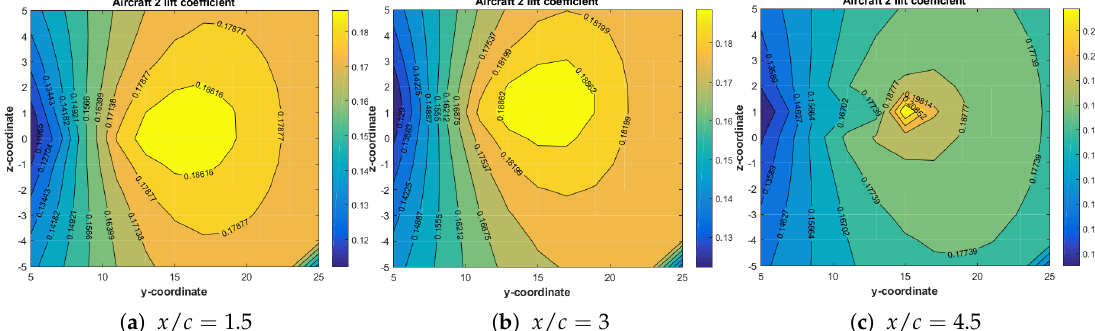
Figure 15. Lift coefficient contours of blended-wing-body configuration in double tandem formation flight of the trailing aircraft on y-z plane at three different stream-wise positions.